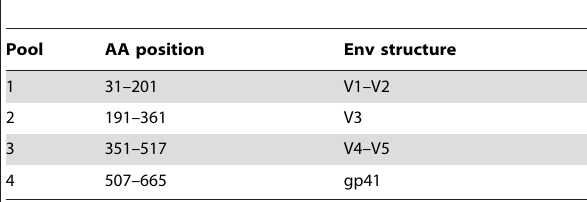
Table 1. Aminoacid residues included in each of the four peptide pools used for in vitro stimulations, and their location in the Env protein